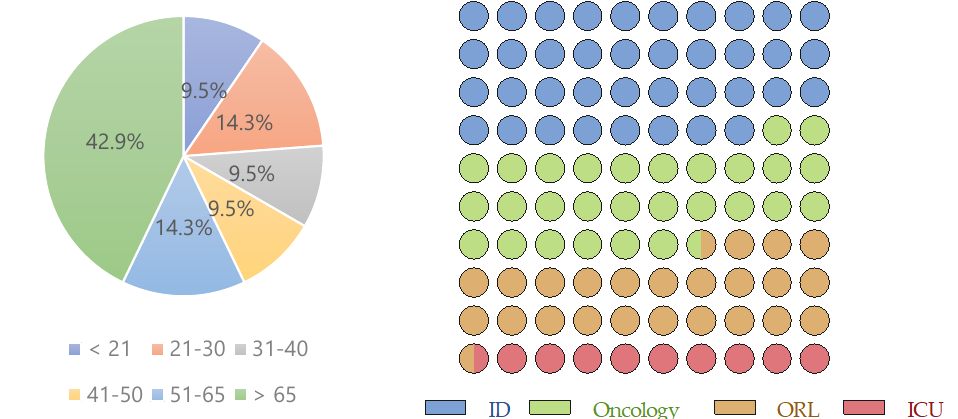
Figure 1. Distribution and percentage of ages and samples collected from specific hospital wards. ( n = 21; Female: n = 8, 38.1%; Male: n = 13, 61.9%; ID—infectious diseases; ORL—otorhinolaryngology” (ORL) and ICU—intensive care